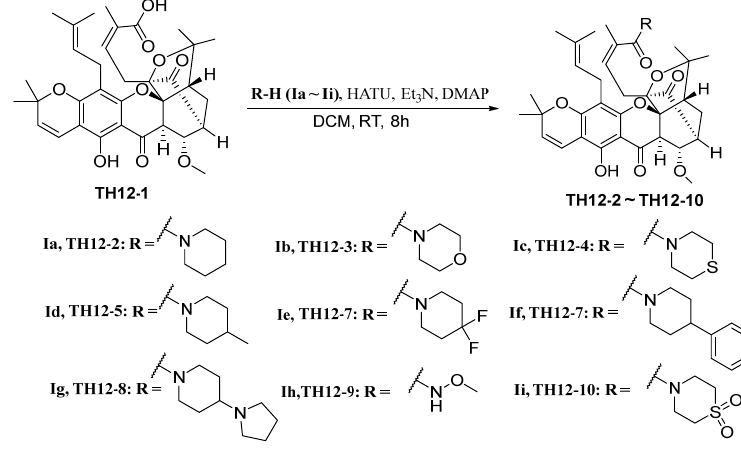
Scheme 1. The synthesis pathway of compounds TH12-2 ~ TH12-10.